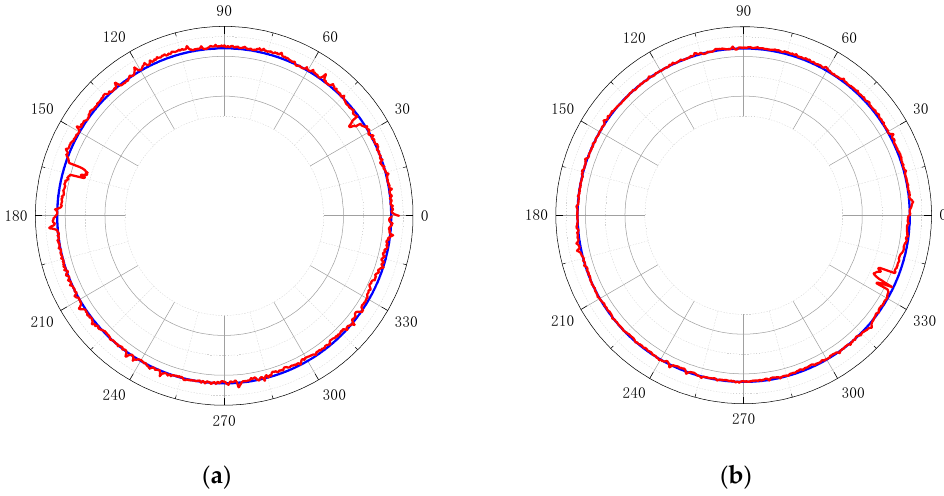
Figure 20. The defect conditions of the chosen wheels: ( a ) Front wheel; ( b ) rear wheel.